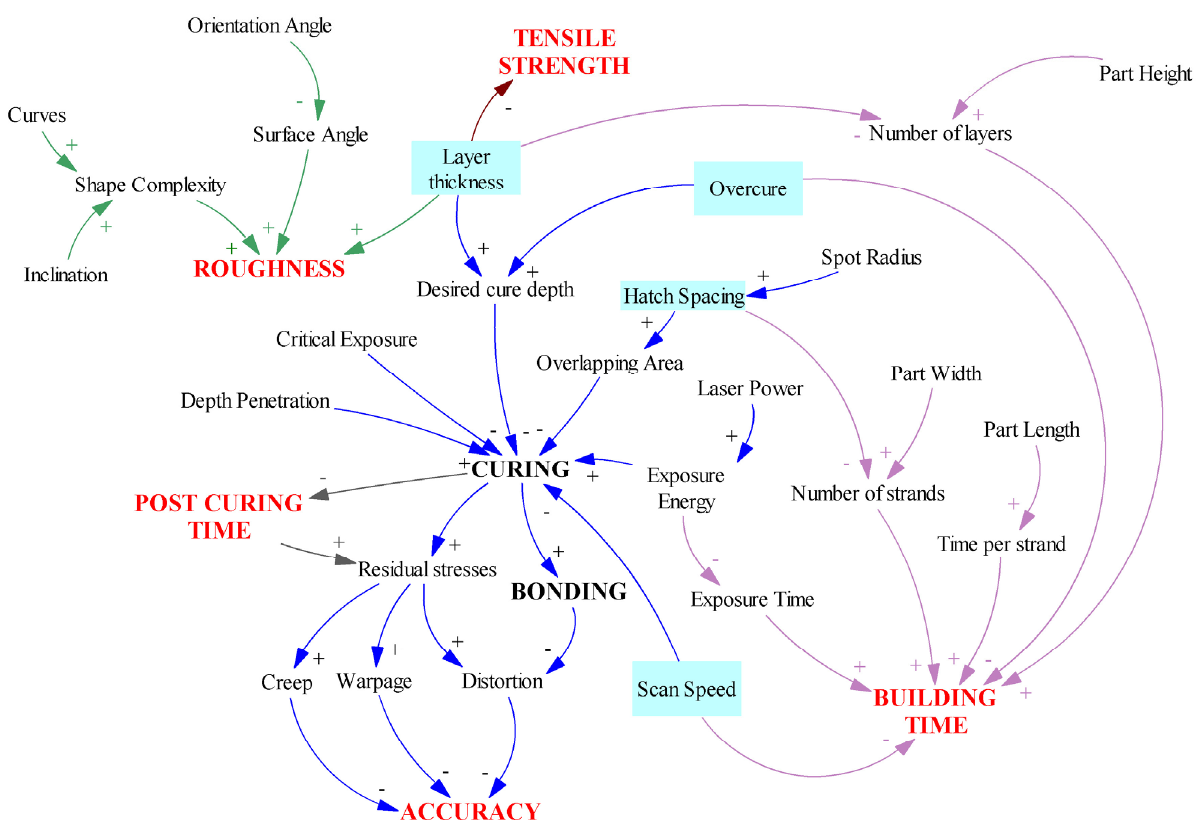
Figure 15. Casual loop diagrams for SLA process parameters [102].